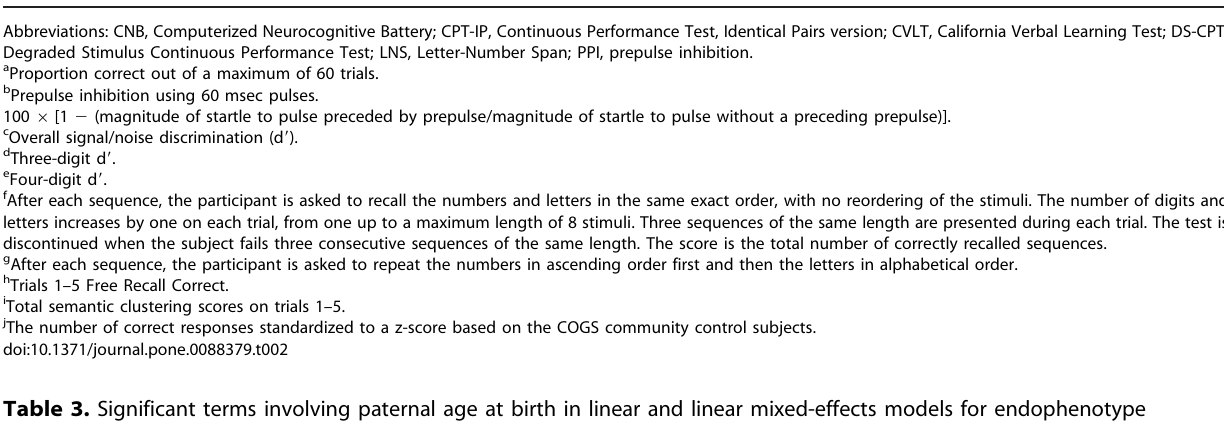
Table 3. Significant terms involving paternal age at birth in linear and linear mixed-effects models for endophenotype